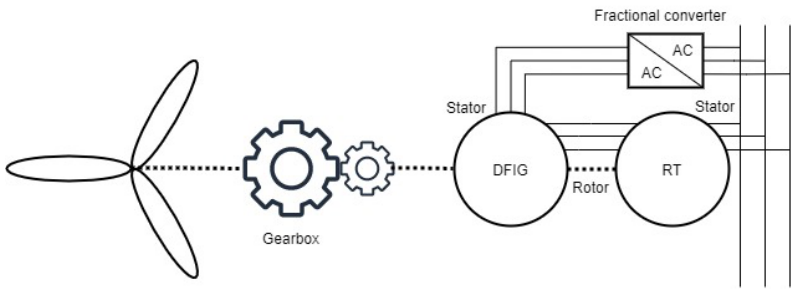
Figure 1. The rotor-tied DFIG with a rotary